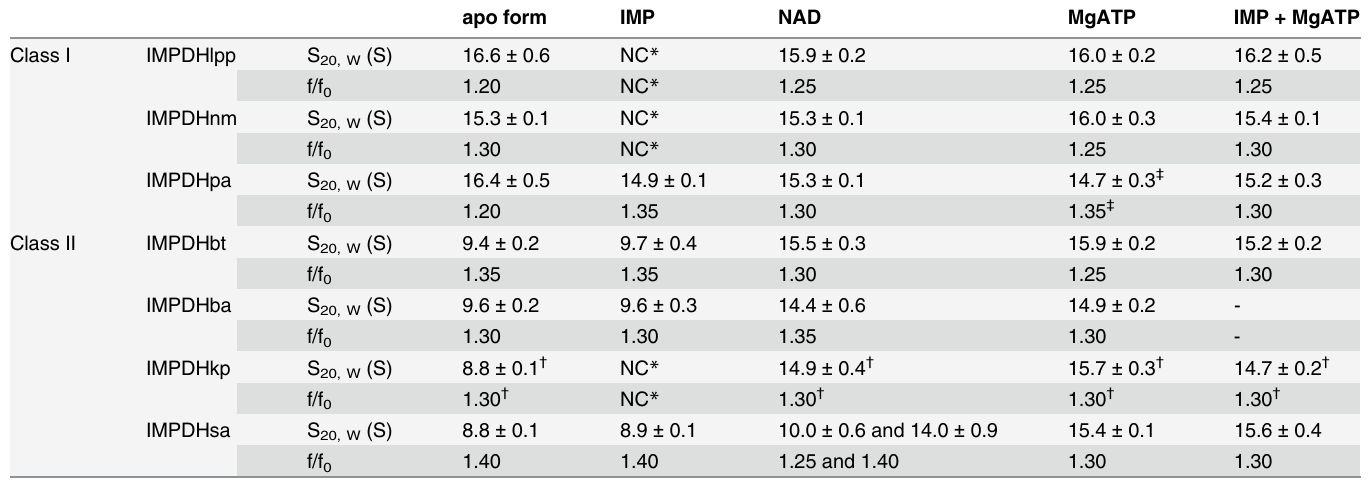
Table 4. Hydrodynamic characteristics of six bacterial IMPDHs at a single concentration (1mg/mL corresponding to 18.3, 18.4, 18.6, 18.5, 18.3, 18.4 and 18.2 μ M for IMPDHlpp, IMPDHnm, IMPDHpa, IMPDHbt, IMPDHba, IMPDHkp and IMPDHsa, respectively) in the absence or presence of IMP (10 mM), NAD (7 mM for IMPDHsa; 3 mM for the others) and MgATP (3 mM).